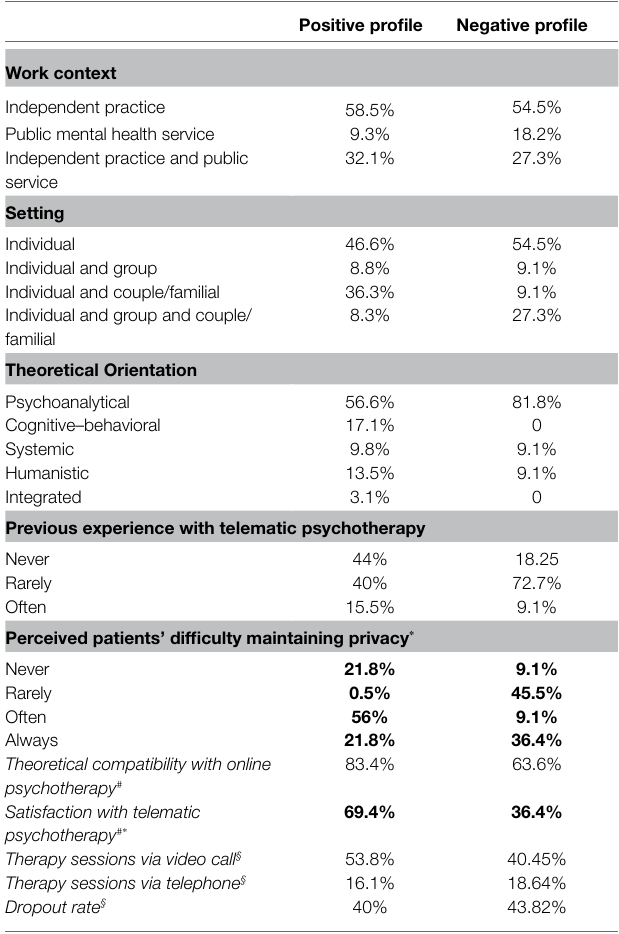
TABLE 2 | Differences between positive and negative self-experience profiles. Positive profile Negative